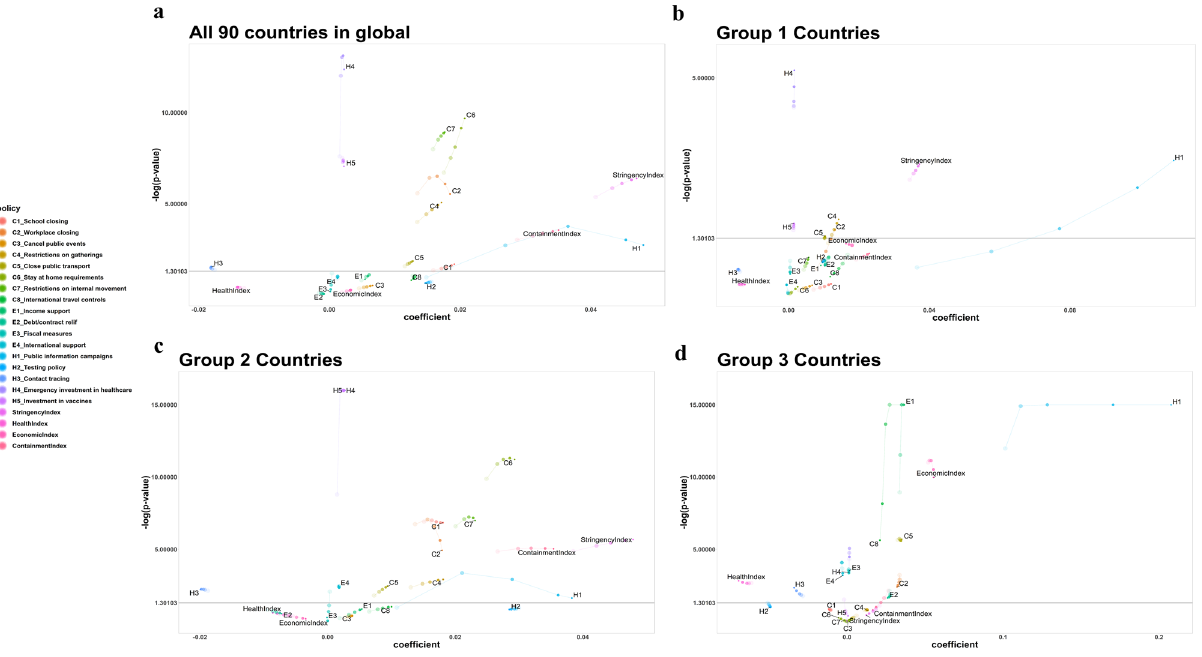
Figure 1. Lagging effect in the subgroup analysis. Variation of coefficients and p values of policies and indices according to groups is shown. The size and transparency of the circular dots increase with the time lag (0, 3, 7, 10, 14). ( a ) Analysis of all 90 countries shows C1, C2, C4, C5, C6, C7, H3, H4, H5, SI, and CoI are significant at all time lags. ( b ) Group 1 analysis shows H4, H5, and SI are significant at all-time lags. ( c ) Group 2 analysis shows C1, C2, C4, C5, C6, C7, E4, H3, H4, H5, SI, RI, CI, and CoI are significant at all-time lags. ( d ) Group 3 analysis shows C2, C5, C8, E1, E2, E3, E4, H1, H3, H4, HI, and EI are significant at all-time Analysis of Group 1 for the countries with one wave. Grouping the countries according to the number of waves in their daily confirmed cases showed that significant policies and indices varied with lagging and in the three groups. Figure 1 shows the coefficients and p values of policies and indices for the three groups. For the 31 coun- tries in Group 1 (Fig. 1b), H4 (Emergency investment in healthcare), H5 (Investment in vaccines), SI (Stringency index) were significant at all-time lags and had positive coefficients. However, SI showed a trend of increasing p values and decreasing coefficients with lagging, whereas coefficients of H4 and H5 remained unchanged regard- less of lagging. C2 (Workplace closing), C4 (Restrictions on gatherings), C5 (Closing public transport), H1 (Public information campaigns), and RI (Restriction index) all had positive coefficients and were significant only for short time-lags. H1 had a large coefficient value of 0.1 compared to those of other policies. Other policies including all economic policies were non-significant. Analysis of Group 2 for the countries with two waves. In the 54 countries (Fig. 1c), C1 (School closing), C2 (Workplace closing), C4 (Restriction on gatherings), C5 (Closing public transport), C6 (Stay at home require- ments), C7 (Restrictions on internal movement), E4 (International support), H3 (Contact tracing), H4 (Emer- gency investment in healthcare), H5 (Investment in vaccines), SI (Stringency index), RI (Restriction index), CI (Closing index), and CoI (Containment index) were significant at all-time lags. Among those, only H3 had a negative coefficient value. H3, H4, and H5 showed similar coefficients and p values with lagging whereas others showed a similar trend of increasing p values and decreasing coefficient values with lagging. E3 (Fiscal measures) became significant while H1 (Public information campaigns) became non-significant at 14-days’ lag with both having positive coefficients values.